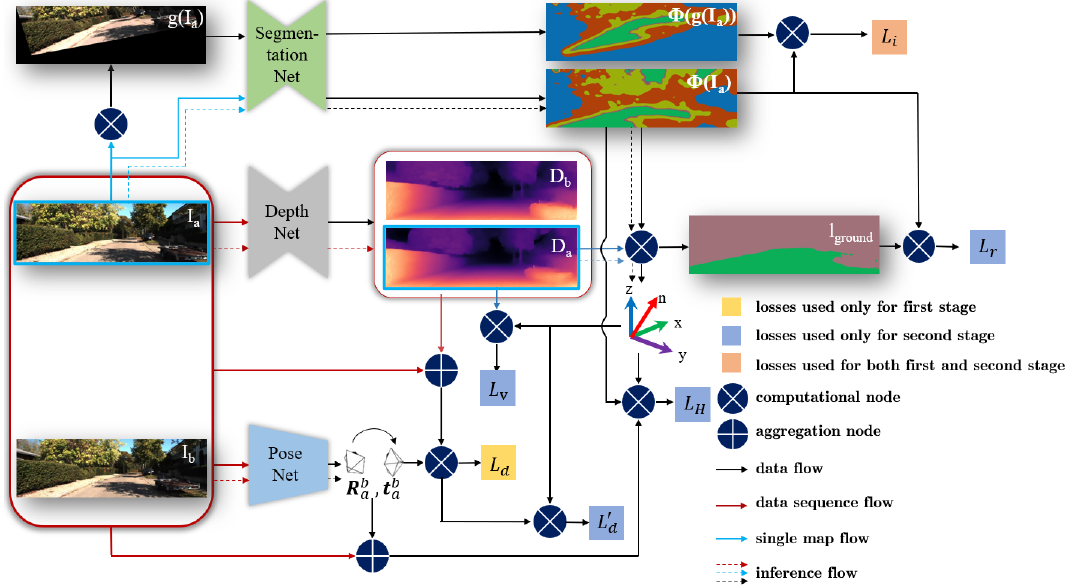
Figure 5. An overview of our entire learning and inference framework. Detailed description about the framework can be seen in the